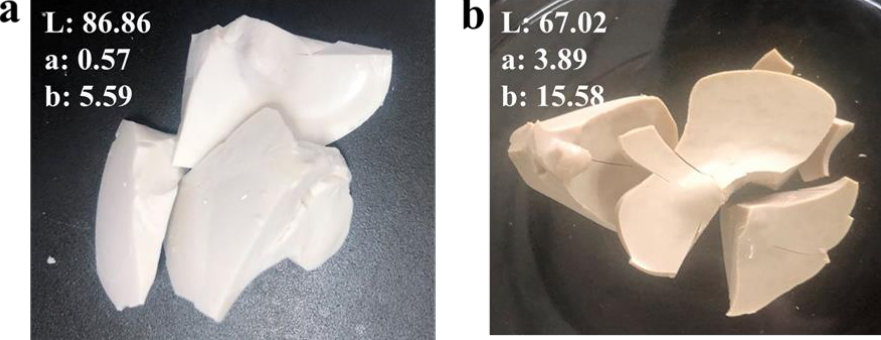
Figure 6. Digital images of ( a ) the rPET with purified BHET and ( b ) the rPET with unpurified BHET.